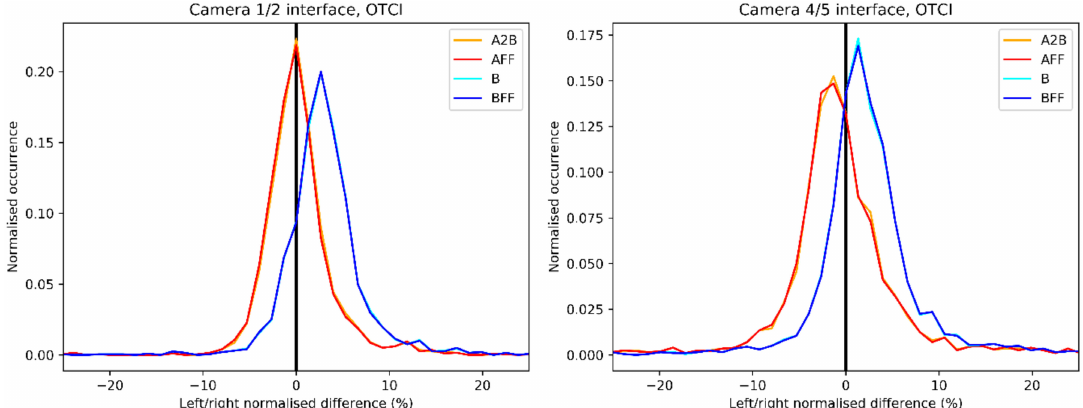
Figure 23. OTCI normalised relative di ff erences between the values obtained from the two adjacent cameras of interface 1 / 2 ( left ) and interface 4 / 5 ( right ) and for the four calibration setups. Flat-fielding is not su ffi cient to reduce di ff erences between A and B at camera interfaces, highlighting their origin in spectral rather than radiometric di ff